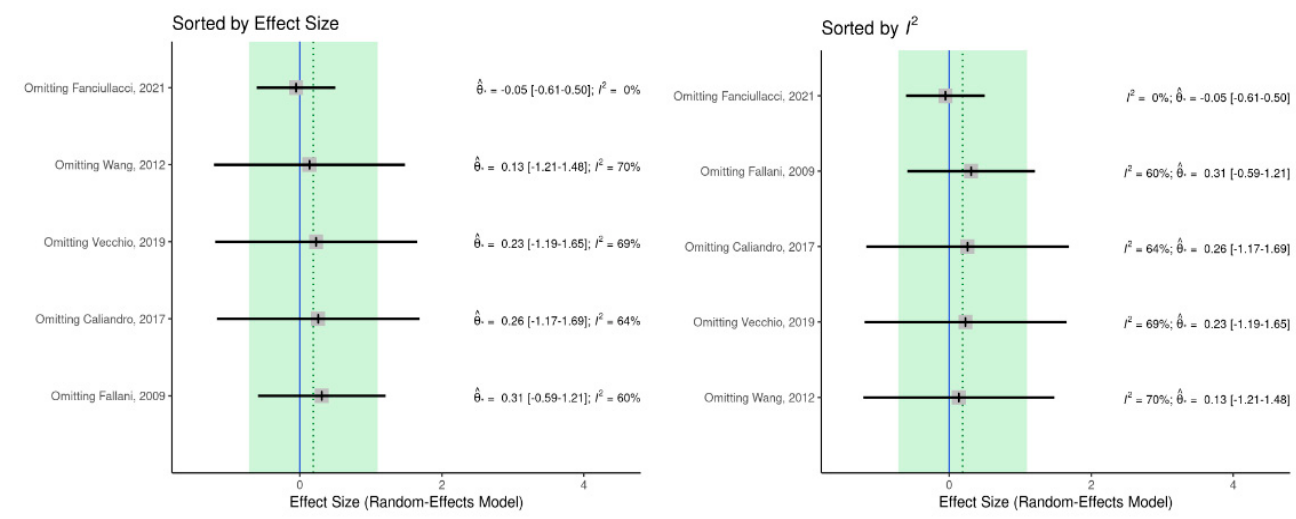
Figure A4. Leave-one-out plots. I 2 : proportion of the variance in observed effect is due to variance in true effects rather than sampling error [7,8,10,12,13].